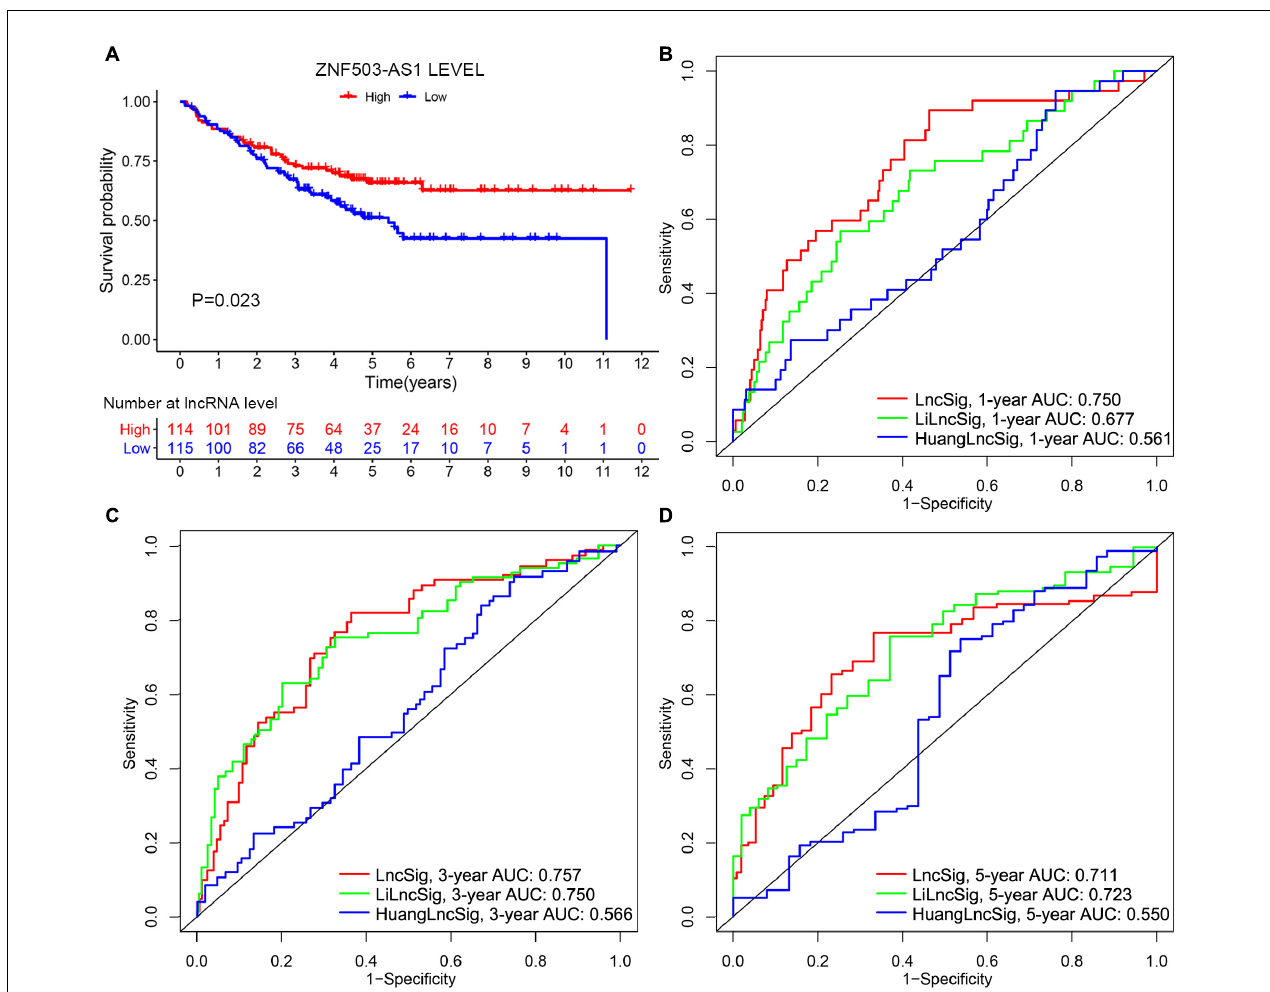
FIGURE 9 | Performance evaluation of lncRNA signature. (A) Independent validation of the lncRNA in lncRNA signature in the GSE17538 dataset. Kaplan–Meier curves illustrated that patients with low expression levels of ZNF503-AS1 had worse overall survival than those with high expression levels ( P value = 0.023). 1-year (B) , 3-year (C), and 5-year (D) receiver operating characteristic (ROC) analyses for our lncRNA signature (lncSig), Li lncRNA signature (LiLncSig) and Huang lncRNA signature (HuangLncSig). AUC, area under the